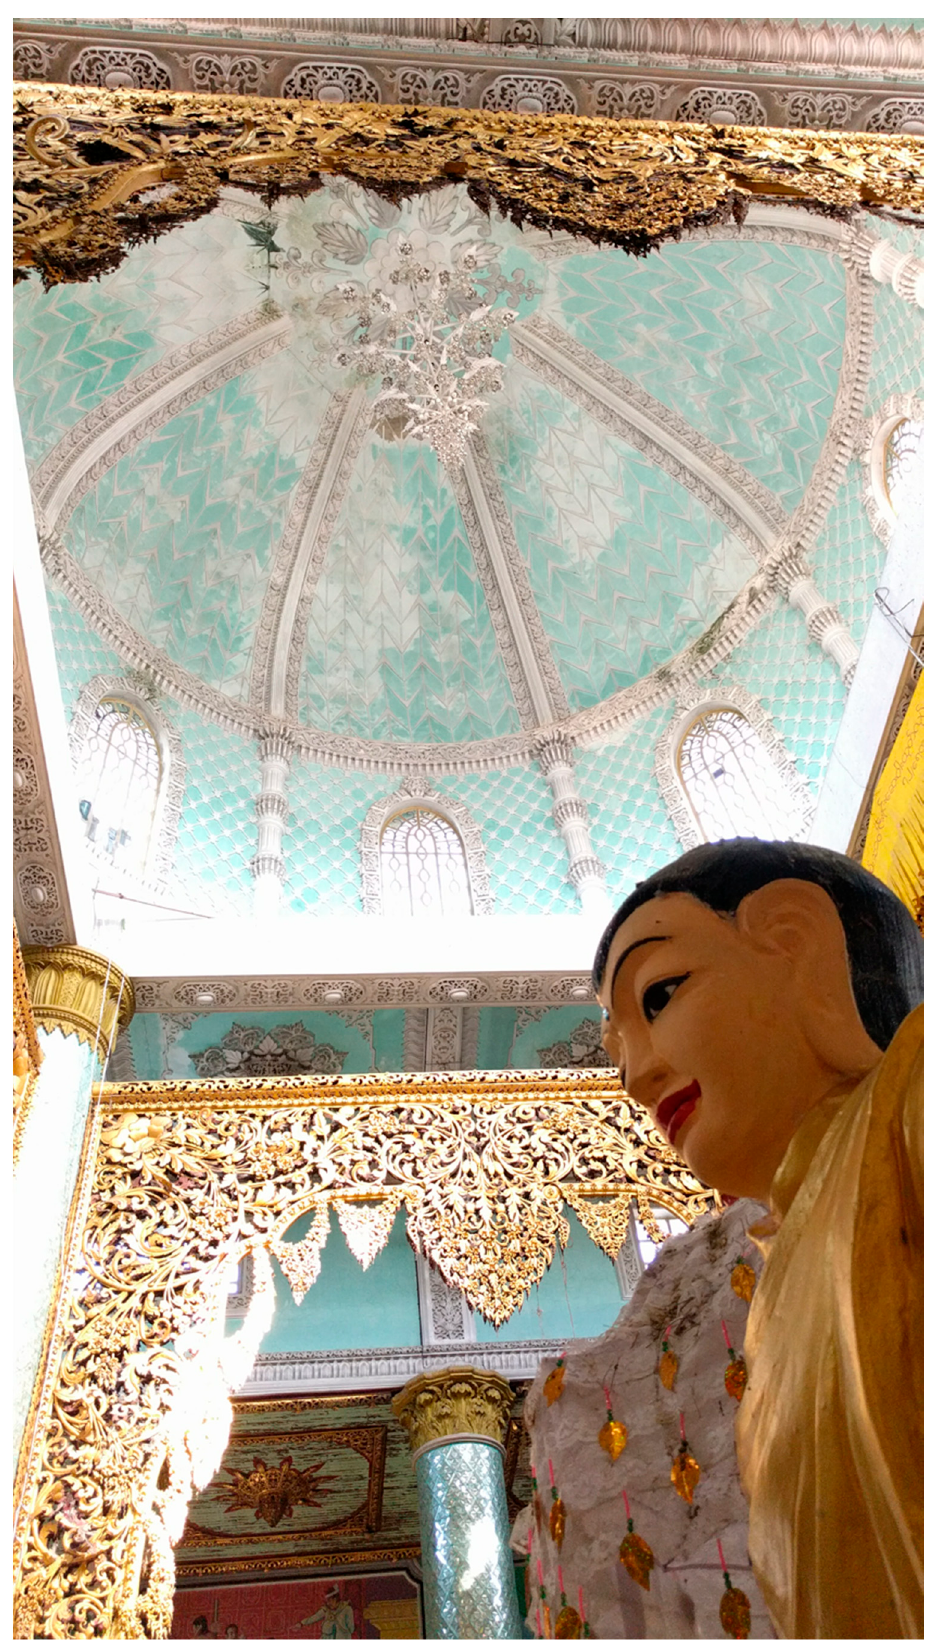
Figure 5. Photograph of the inside of the Arlein Nga Sint Pagoda.